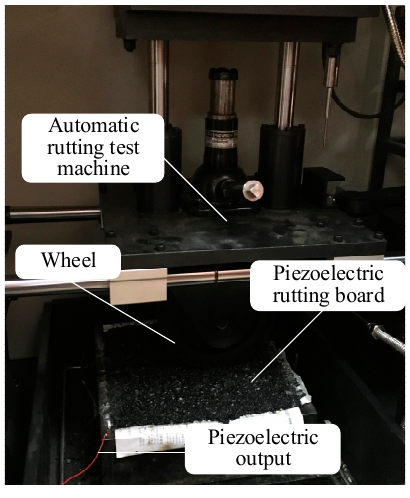
Figure 7. Rutting test equipment.